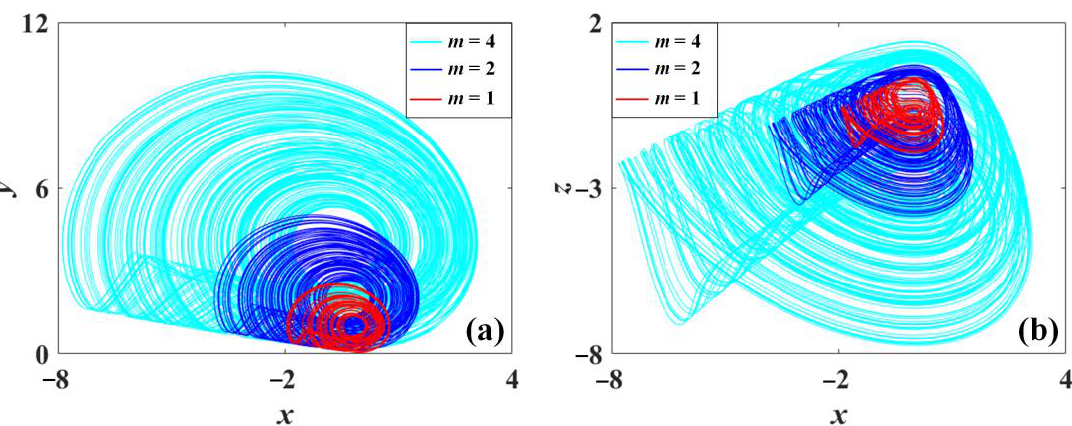
Figure 4. Chaotic oscillation of system (5) with a = 0.5, b = 0.6, and c = 1.2 under initial condition (0,